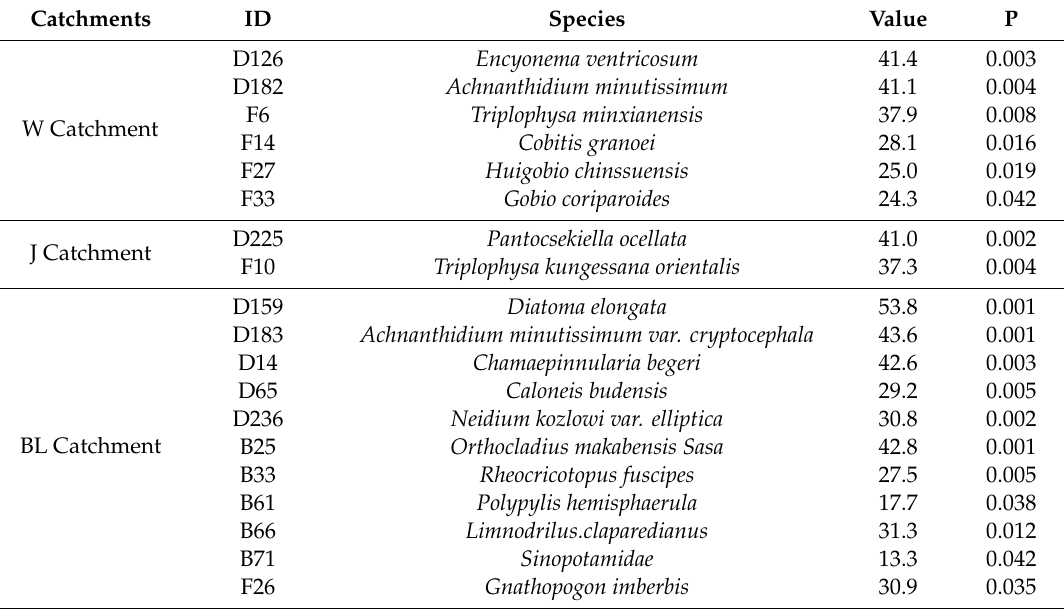
Table 1. Indicator species at each catchment in the Wei River basin. See Appendices A–C for abbreviations of the diatom, macroinvertebrate and fish species.